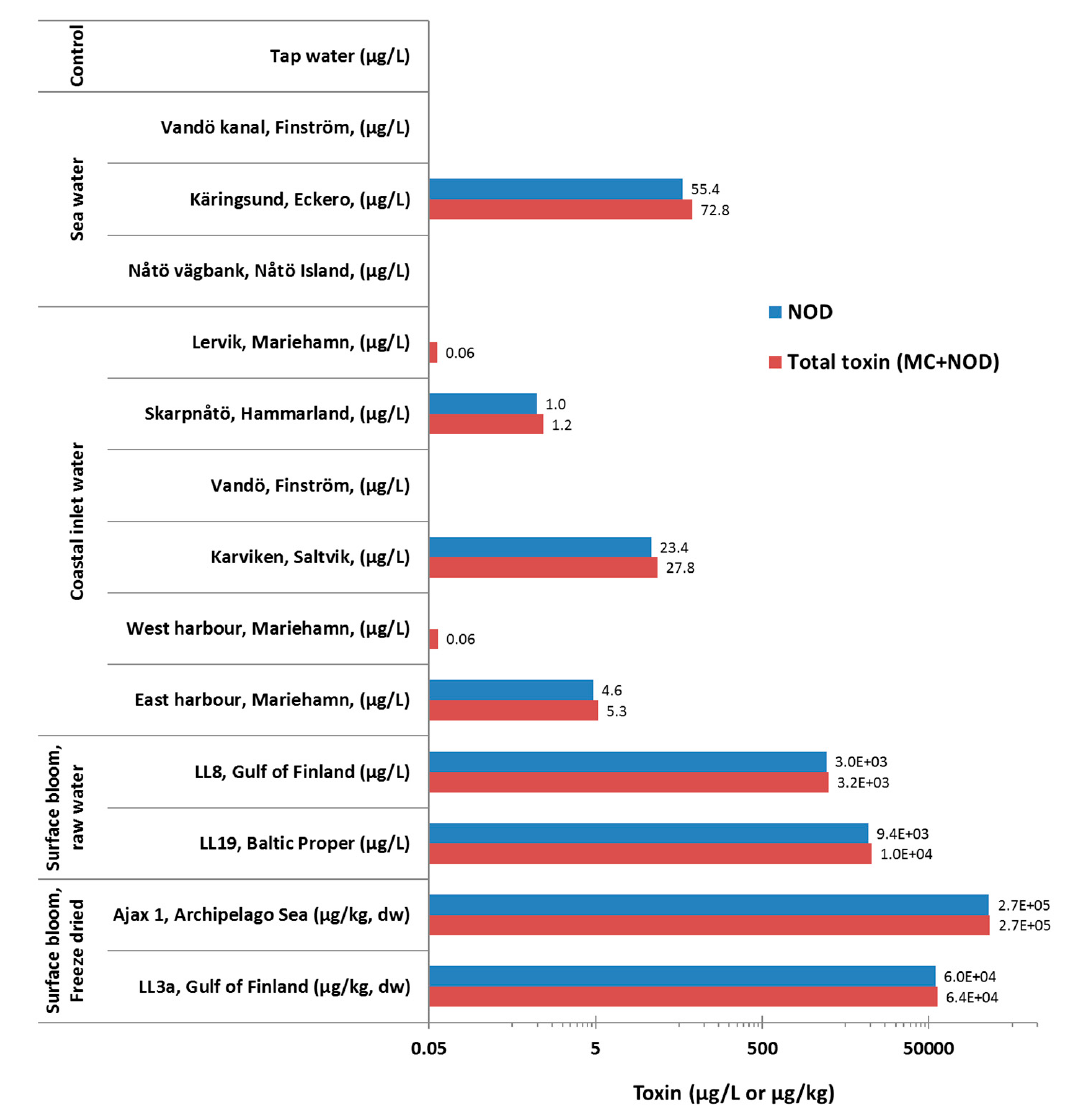
Figure 4. Concentration of NOD and total toxin (MCs and NOD) in environmental water and surface bloom samples. The total toxin concentration was measured with the generic assay [41] using NOD-R as standard.